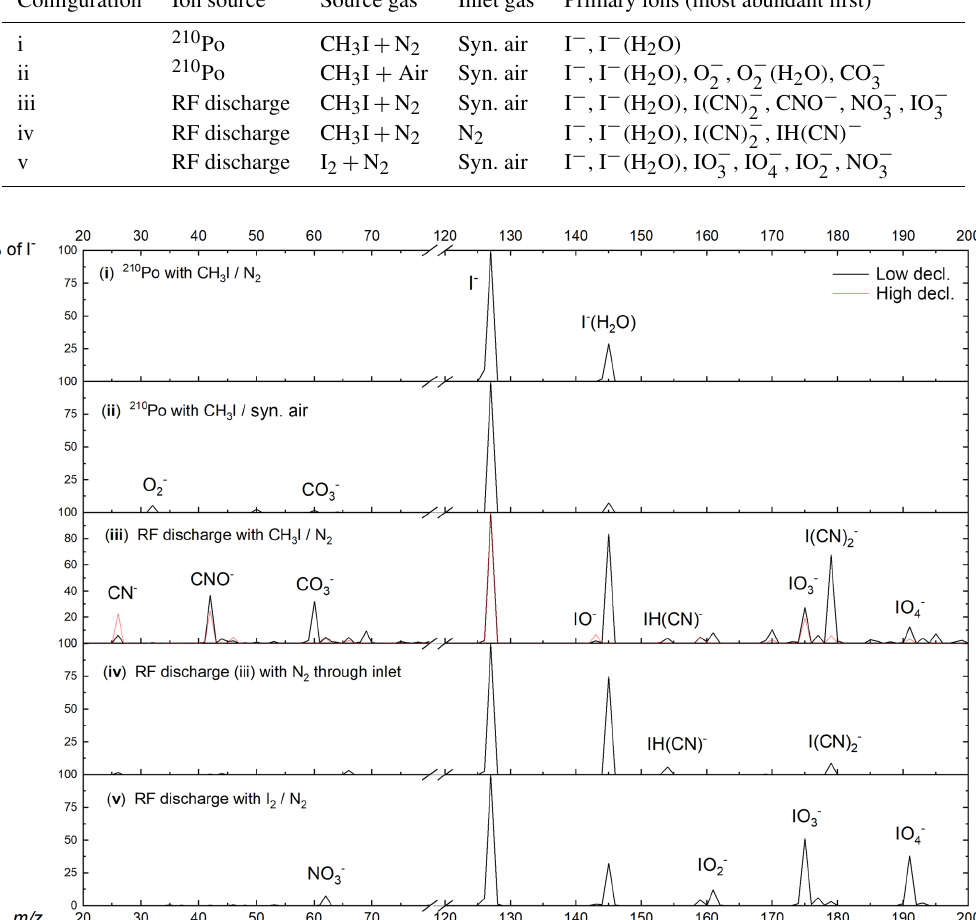
Figure 3. Primary-ion spectra (using I 2 / N 2 (v) or CH 3 I / N 2 (iii–iv) and using either pure synthetic air (iii) or N 2 (iv) for the inlet gas) obtained using the RF discharge (iii–v) or 210 Po (i–ii) as an ion source. The integrated counts (eight channels) for each m/z normalized to the highest peak present are shown, which is I − . For this reason, true peak shapes are not visible. A description of the different configurations can be found in Table